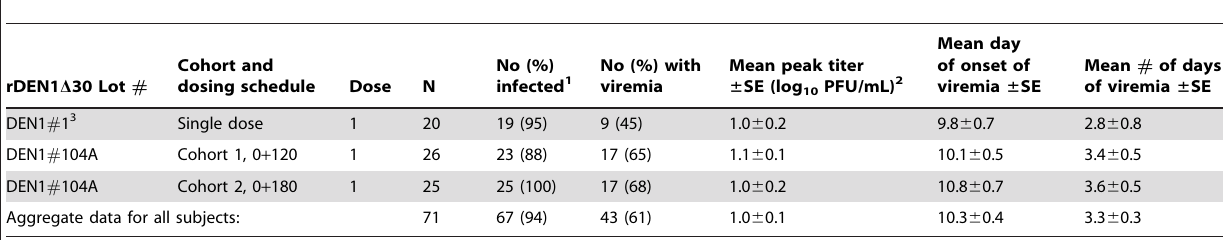
Table 3. Viremia onset, duration, and mean peak titer following a first dose of rDEN1 D 30.